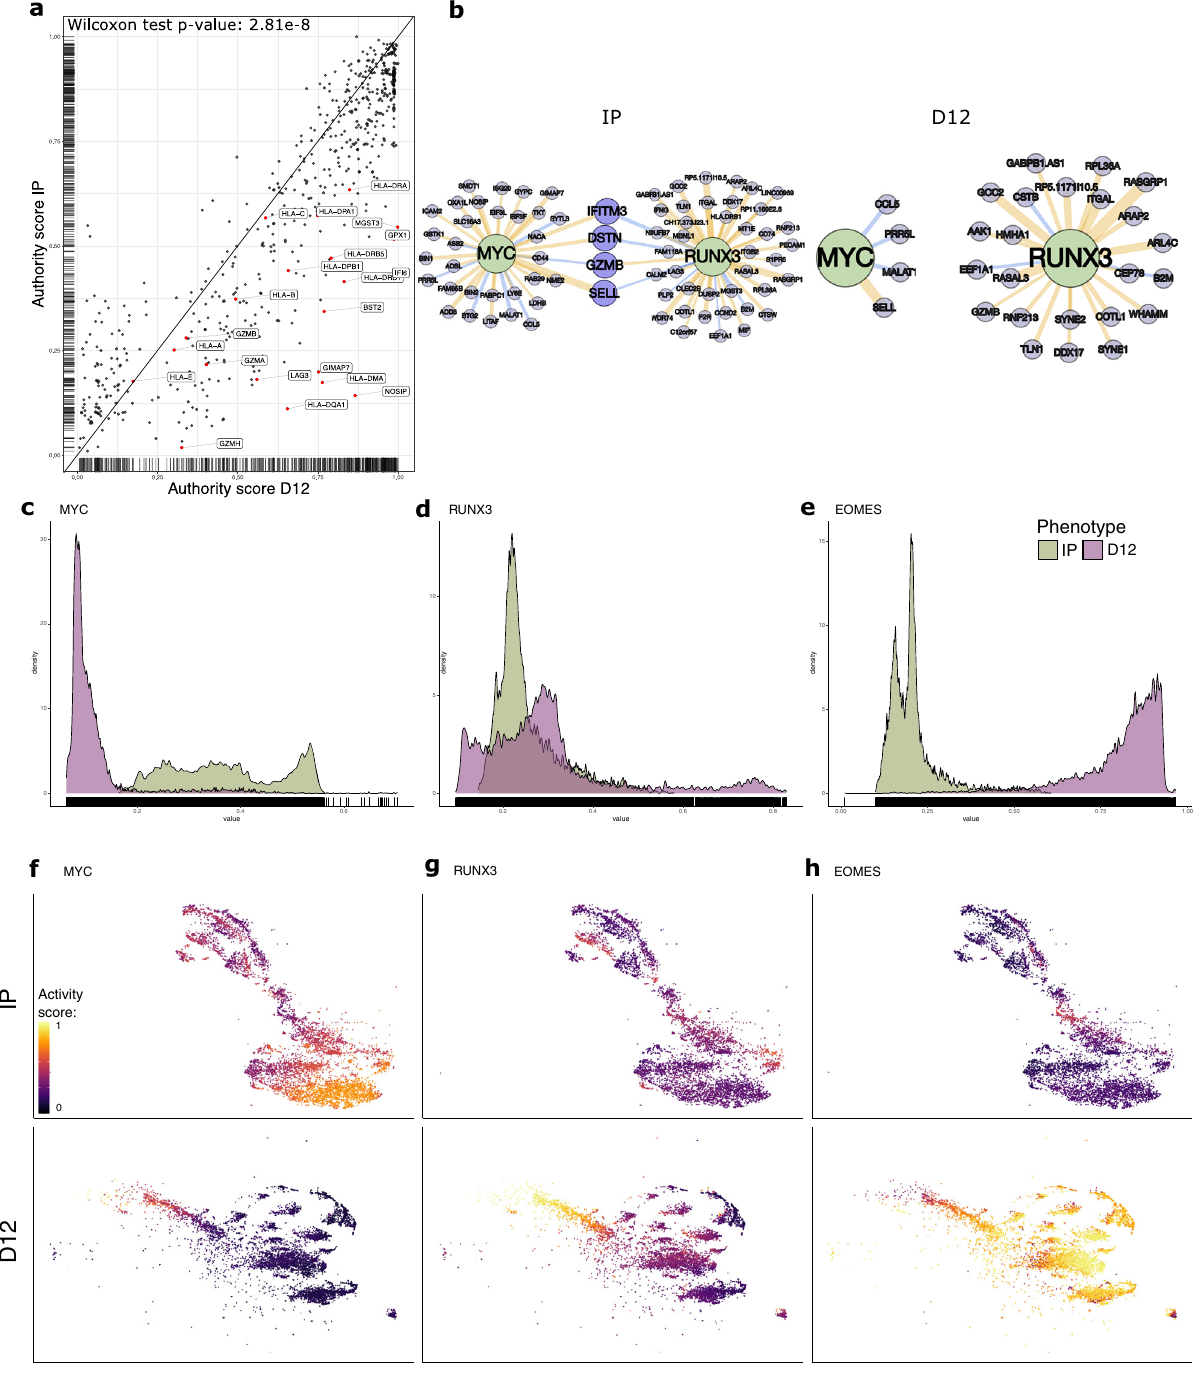
Fig. 4 SimiC captures complex regulatory dynamics within CAR T cells (CD8 + CAR T cell dataset 52 ). a Comparison of the authority scores for each target gene in the two phenotypes IP and D12. We observe an increment of the authority score in D12 as compared to IP (Wilcoxon rank test, FDR < 0.05). b Network representing the weighted regulons of the transcription factors MYC and RUNX3 for the considered phenotypes IP and D12. The color of the edges linking the TFs with their corresponding target genes indicates whether the regulation is positive (yellow) or negative (blue), and the width of the edge corresponds to its strength (i.e., the inferred weight). Regulon activity score distribution for the two different phenotypes IP and D12 for MYC ( c ), RUNX3 ( d ), and EOMES ( e ) regulons. tSNE plots showing the CAR T cells at IP (top) and D12 (bottom) colored by their MYC ( f ), RUNX3 ( g ), and EOMES ( h ) regulon activity score. The peak of activity of the MYC regulon is observed at IP, while at D12 it gets progressively turned off. The RUNX3 regulon has its peak of activity after tumor recognition at D12, while its activity gets turned off once cells get exhausted at D12. Finally, the EOMES regulon gets more active once CAR T cells get exhausted after tumor recognition on